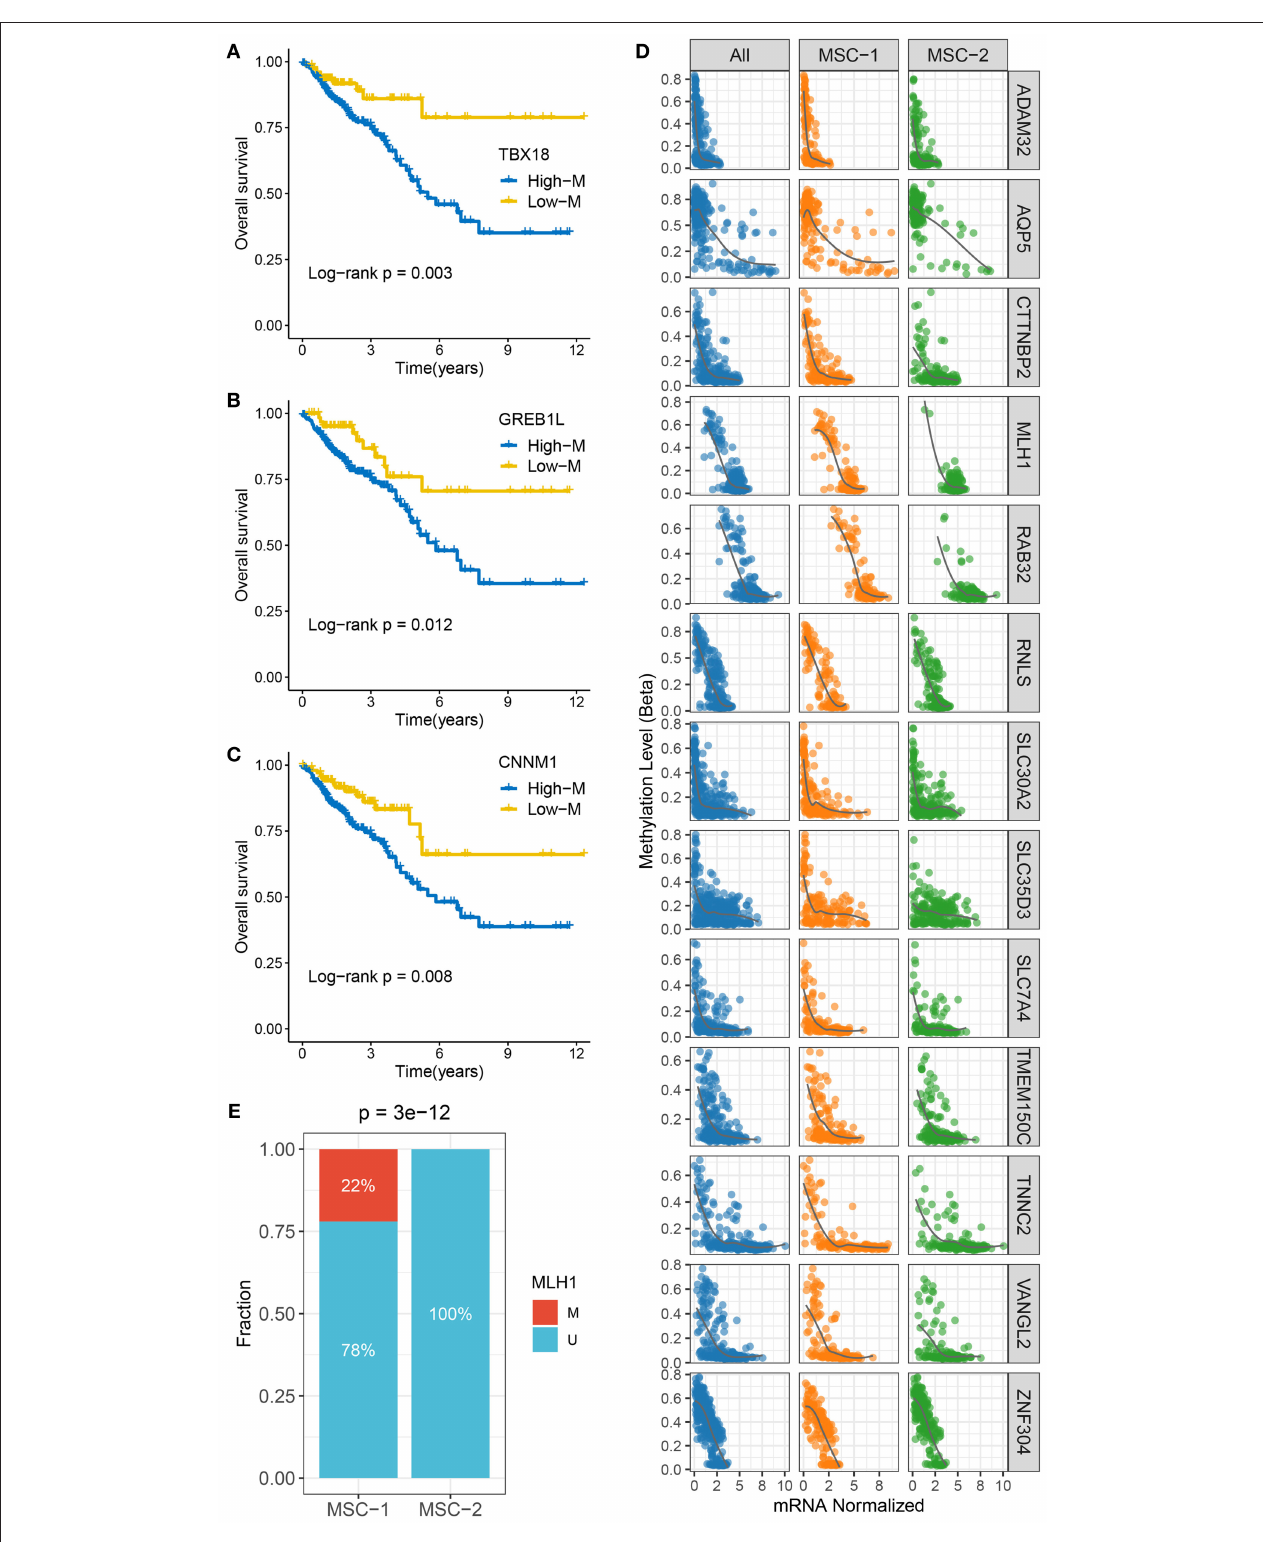
FIGURE 4 | The methylation driven genes in CRC. (A–C) Kaplan–Meier survival analysis of TBX18 (A) , GREB1L (B) , and CNNM1 (C) methylation. (D) The correlation analysis between the methylation and mRNA expression levels of 13 ssMDGs. (E) The relative proportion of patients with the MMR genes methylation events between two